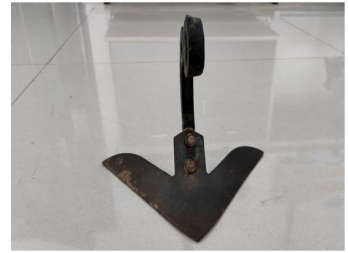
Figure 1. Ditching shovel.